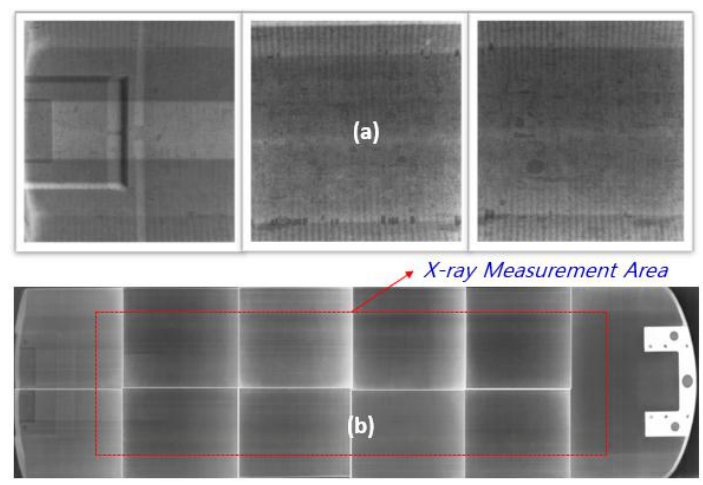
Figure 13. Uniform X-ray transmission of Composite Cradle; ( a ) bad case due to the void, excess resin, and poor resin of face and wrinkle of foam, ( b ) good case - 11 spit-shots of X-ray measurement area.